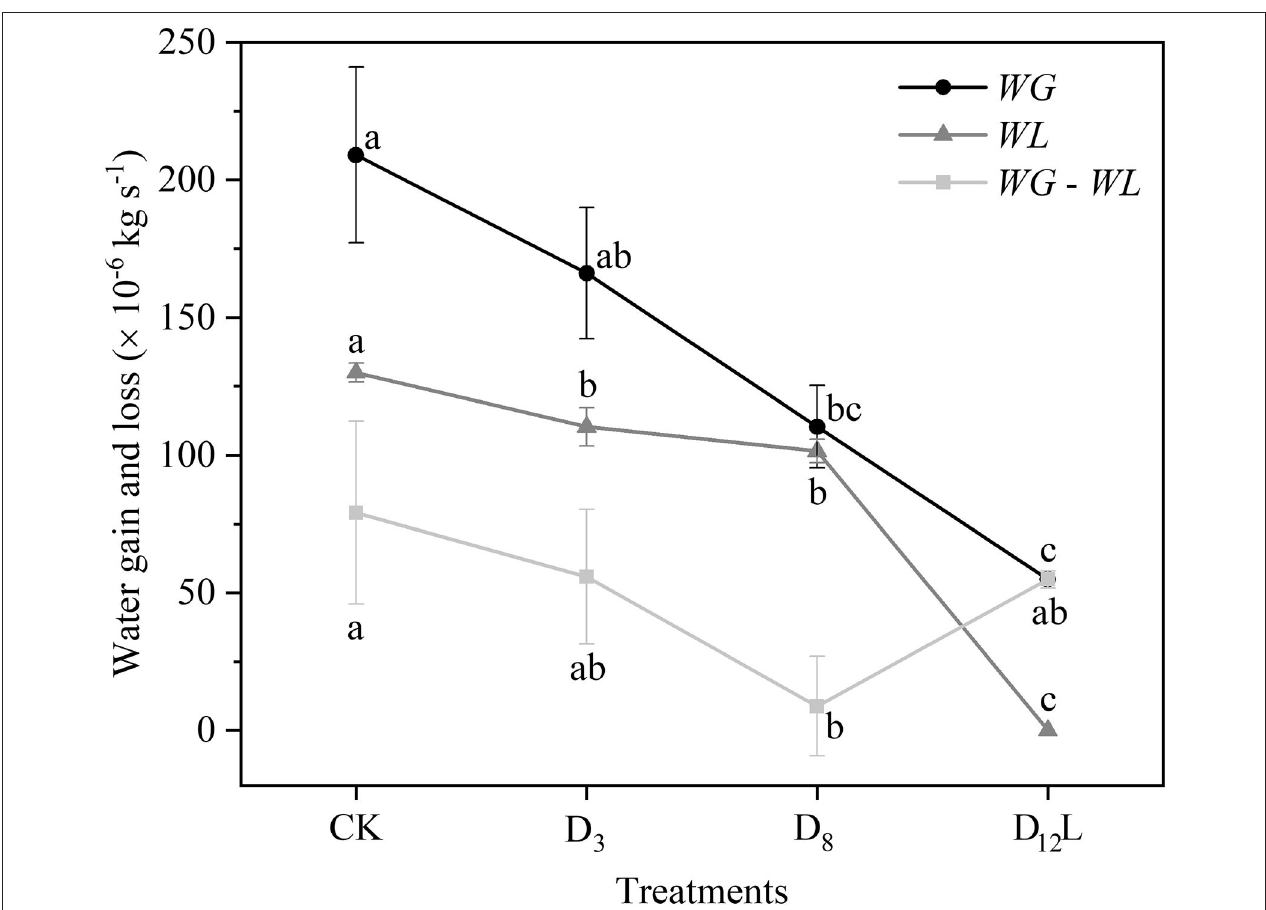
FIGURE 6 | Water gain ( WG ) and water loss ( WL ) of CK, D 3 , D 8 , and D 12 . CK, control group; D 3 , mild drought group; D 8 , moderate drought group; D 12 L, lower part of the severe drought group. Black circles represent WG , gray triangles indicate WL , and light gray squares represent the difference between WG and WL. The data is represented by the mean ± 1 SE and n = 10. One-way ANOVA and Duncan multiple comparisons were performed to detect the differences among WG and WL and WG – WL in CK, D 3 , D 8 , and D 12 L. In addition, different letters indicate significant differences, where P <